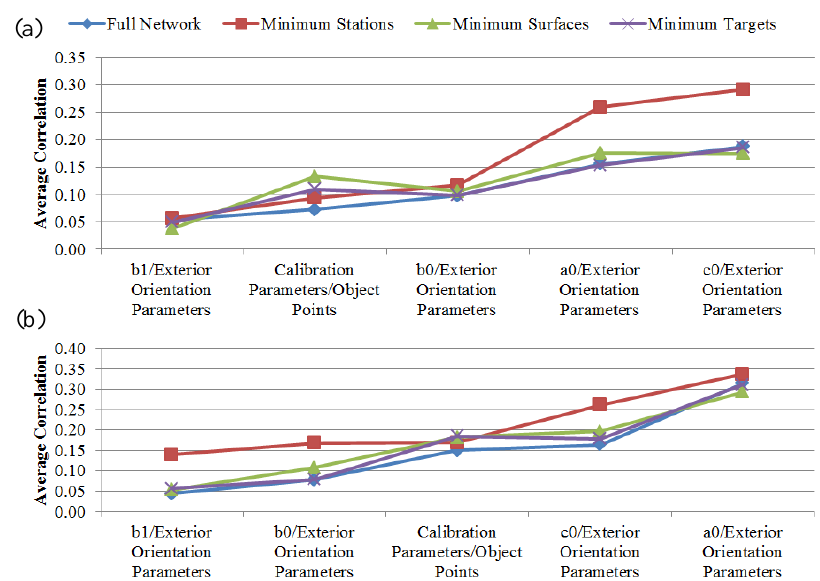
Figure 11. Average parameter correlation (of inner and minimum constraints) with respect to the network configurations), (a) Faro Photon 120 and (b) Faro Focus